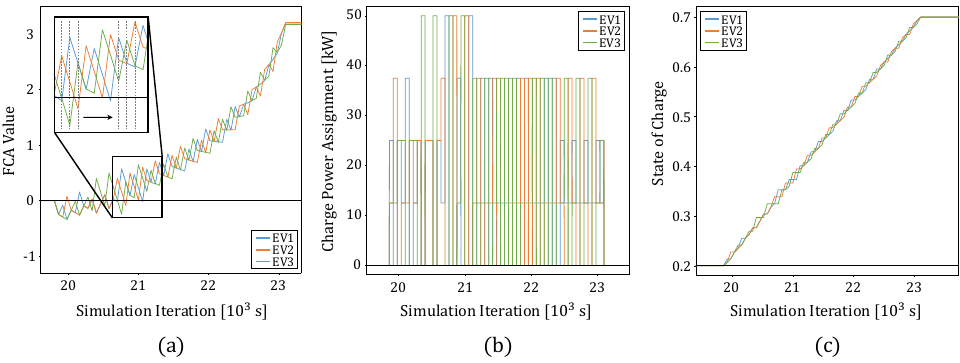
Figure 12. Simultaneous Trio. ( a ) Feeding Compensation Account, ( b ) Charge Power and ( c ) State of